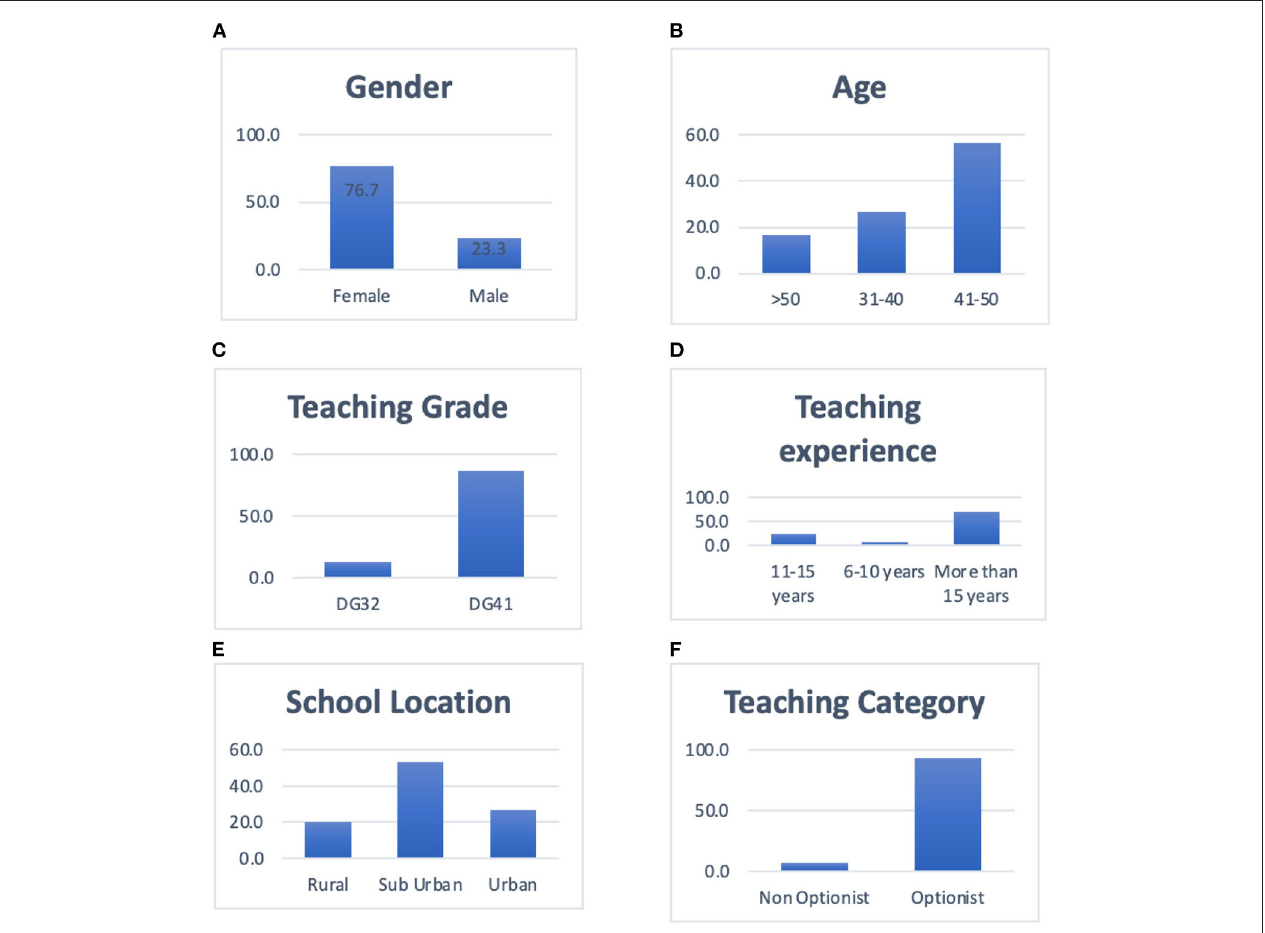
FIGURE 1 | Bar chart for demographic profile. (A) Bar chart for gender. (B) Bar chart for age. (C) Bar chart for teaching grade. (D) Bar chart for teaching experience. (E) Bar chart for school location. (F) Bar chart for teaching